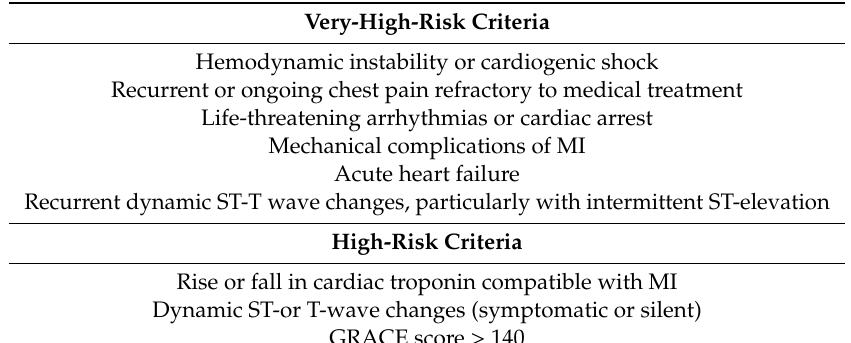
Table 1. Risk criteria mandating invasive strategy in non-ST segment elevation acute coronary